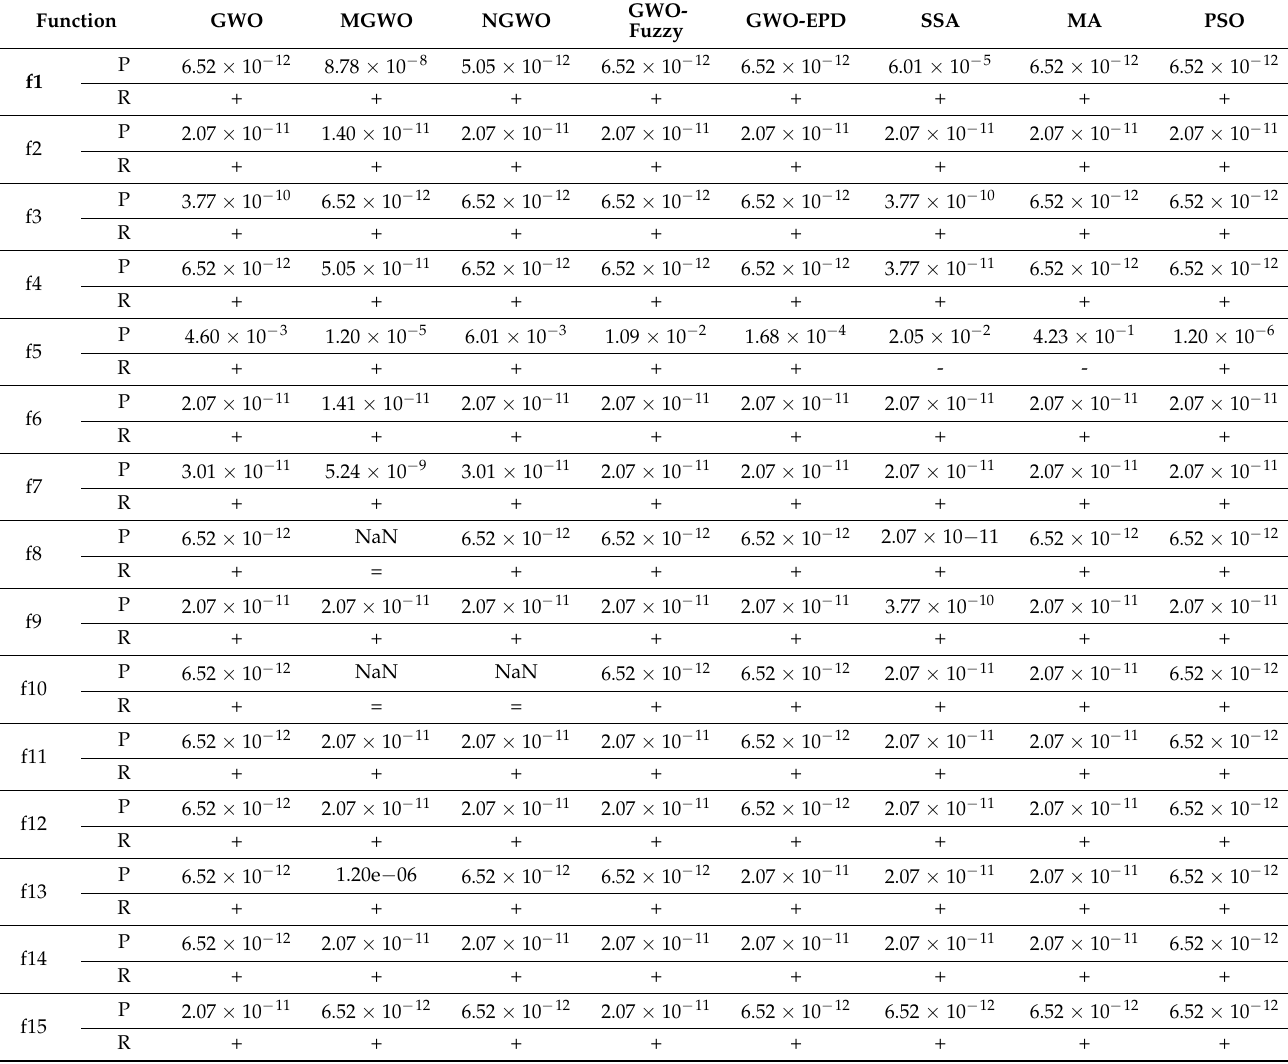
Table 5. Wilcoxon’s rank test of Improved GWO and other algorithms on 15 benchmark